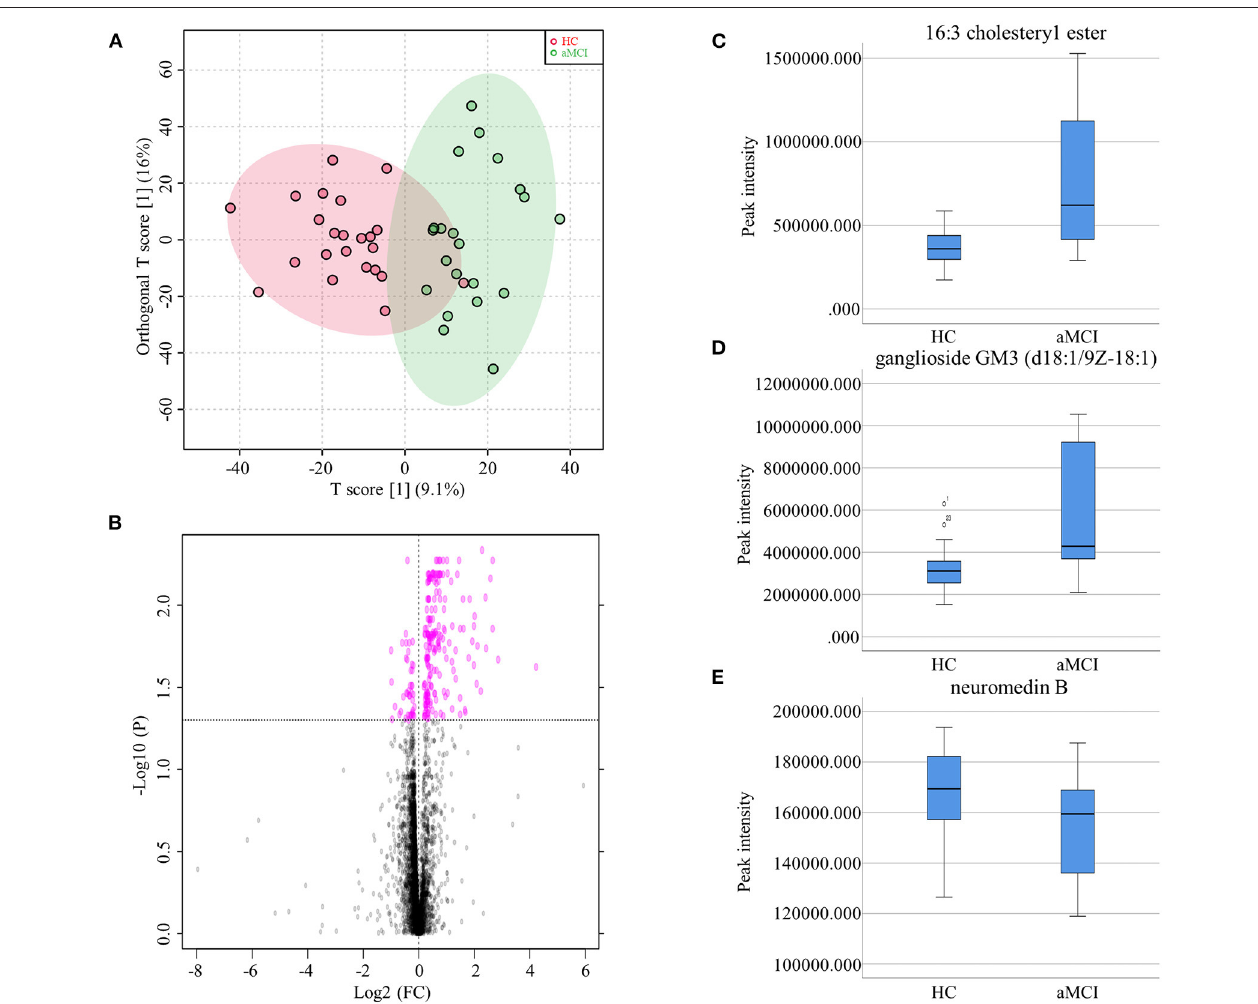
FIGURE 3 | (A) Orthogonal partial least squares discriminant analysis diagram of HC and aMCI comparison. (B) Volcano Plots of HC and aMCI comparison. (C) Box plots showed the different peak intensity of 16:3 cholesteryl ester between HC and aMCI groups. (D) Box plots showed the different peak intensity of ganglioside GM3 (d18:1/9Z-18:1) between HC and aMCI groups. (E) Box plots showed the different peak intensity of neuromedin B between HC and aMCI groups.